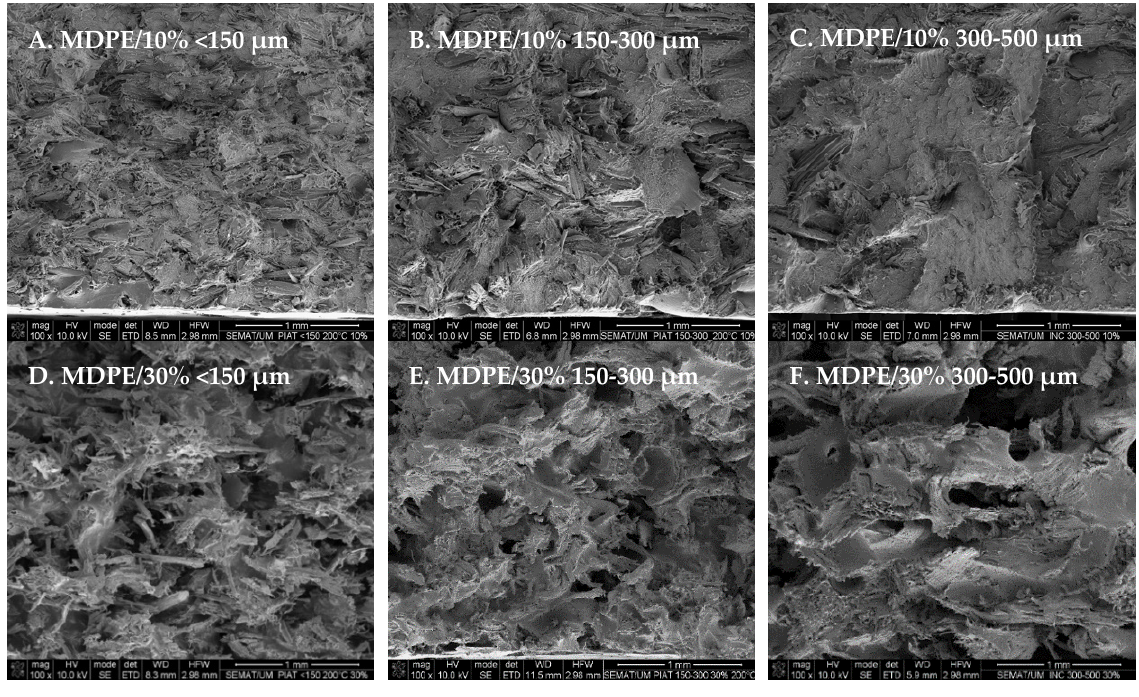
Figure 9. Effect of wood granulometry and wood content on the morphology of MDPE/wood composites.